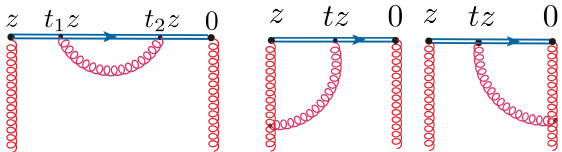
Figure 1: Self-energy-type correction for the gauge link and vertex diagrams with gluons coming out of the gauge link.